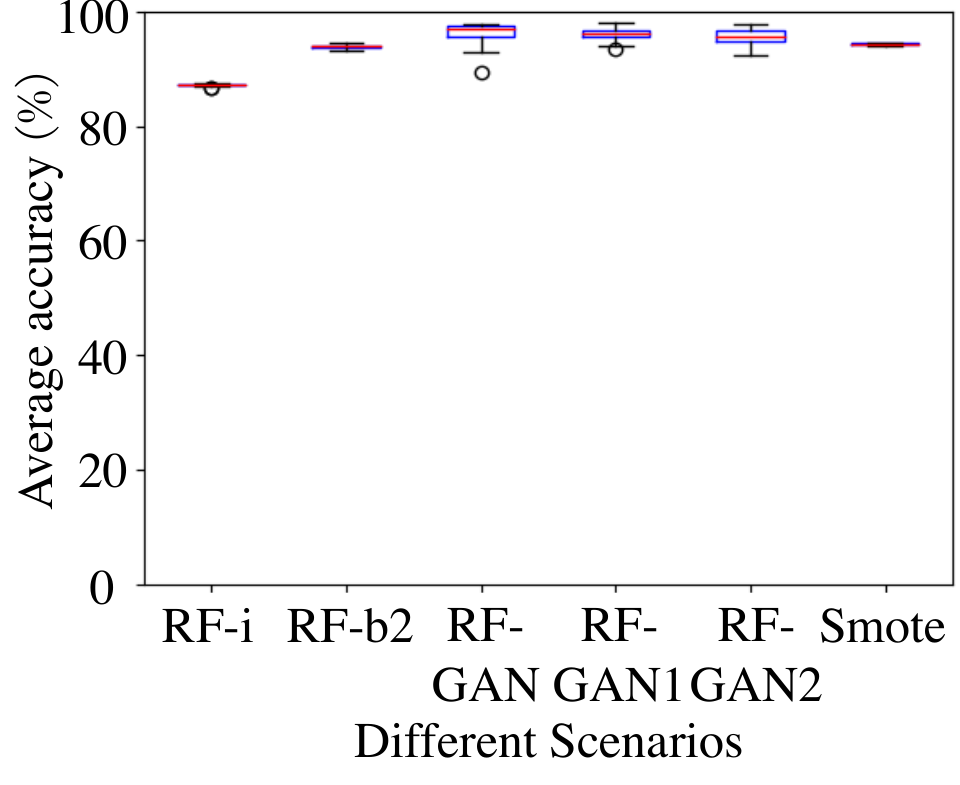
Figure 10. Boxplots exhibiting the relative distributions of accuracy obtained with the different scenarios considered for fault classification. See text for